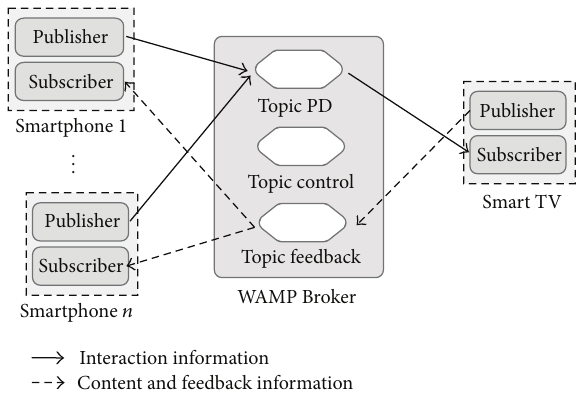
Figure 3: Interaction, content, and feedback information